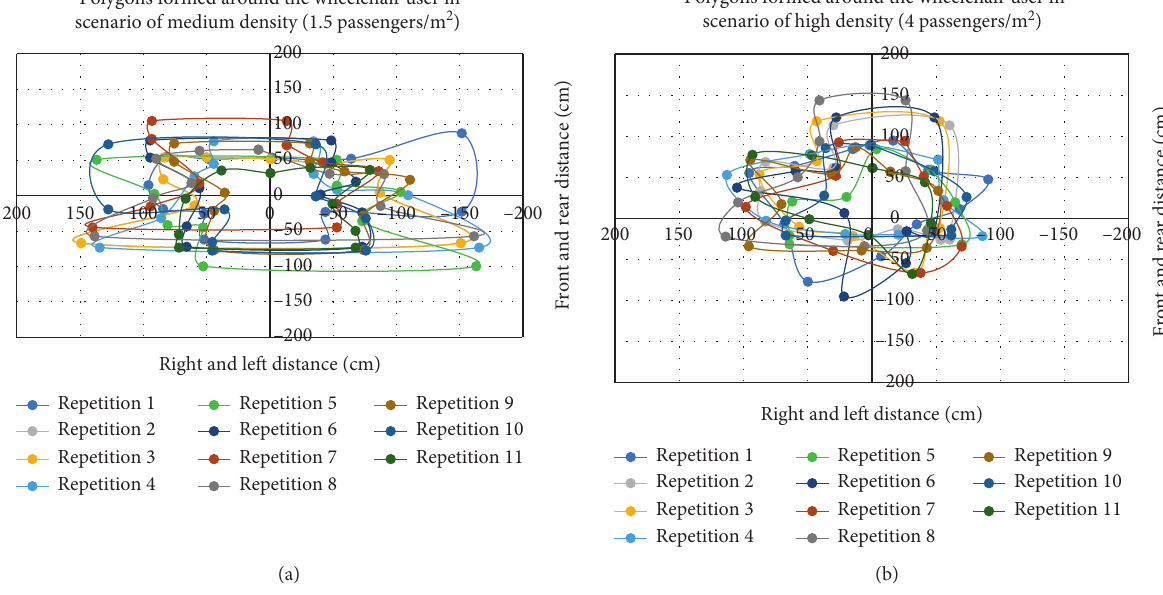
Figure 8: Graphical representation as polygons (measured in cm) of the space occupied by a wheelchair user in each scenario considering the total number of